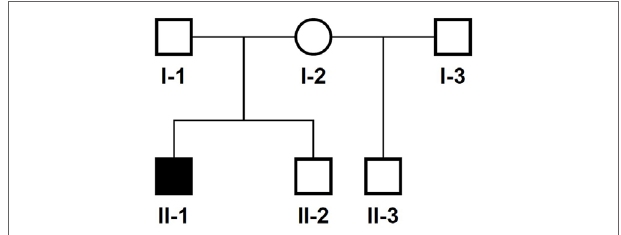
FIgURe 1 | Pedigree of the family. Solid symbol, affected individual; circles, females; squares,